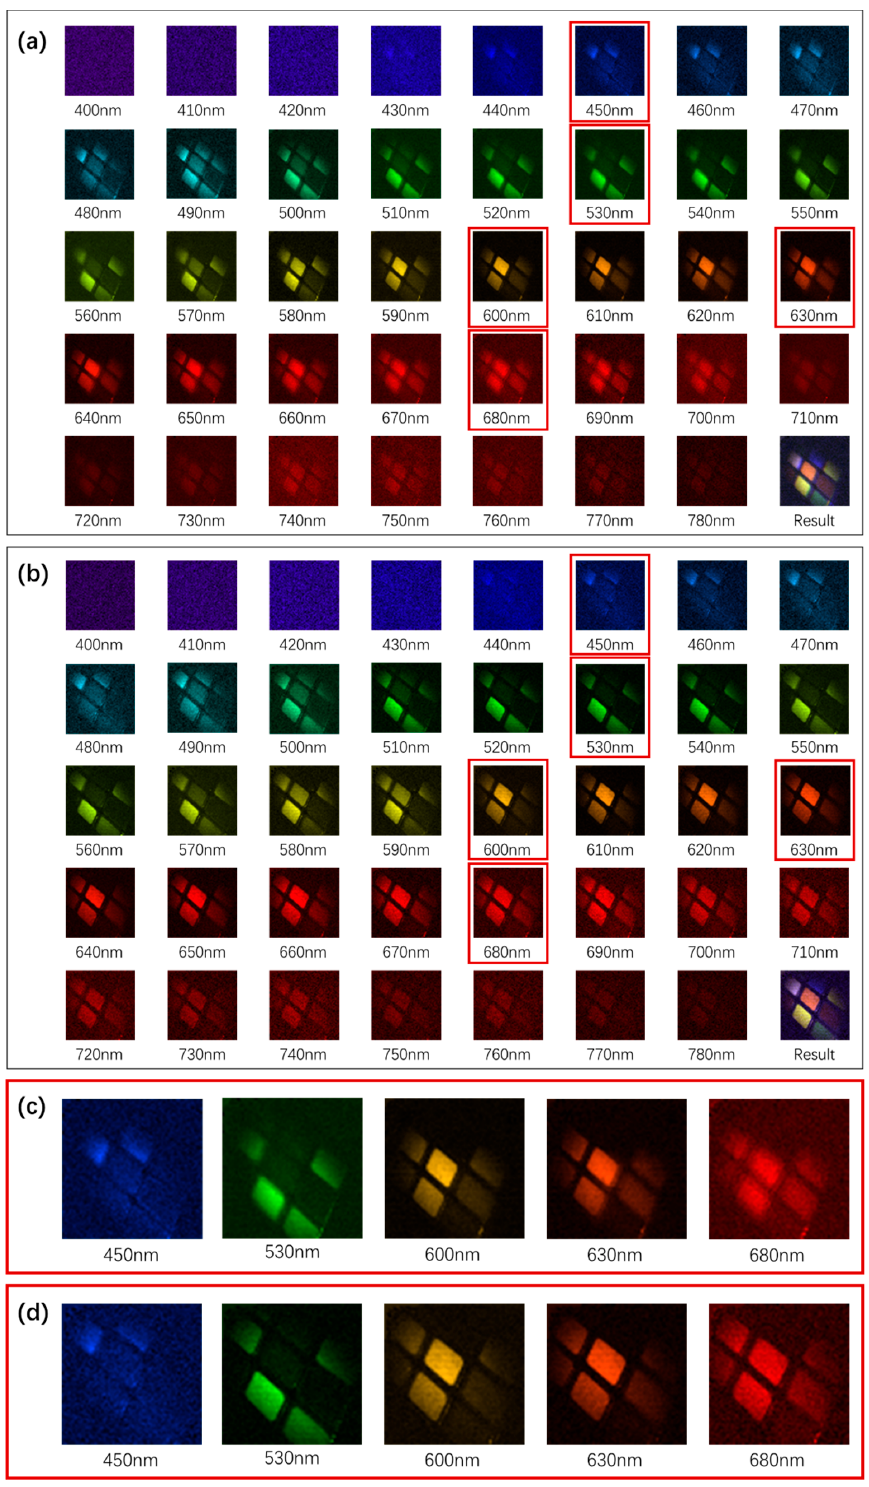
Figure 7. Reconstructed hyperspectral images over 400 ‒ 780 nm in the control ( a ) and TV lens ( b ) groups, with their composite-colored images in the last figure. ( c , d ): Enlargements of the respective images in the red boxes of ( a , b ) reveal that sharp edges are only seen in the yellow bands of the single-lens system, while they are distinct over the vast majority of band range of the TV system.